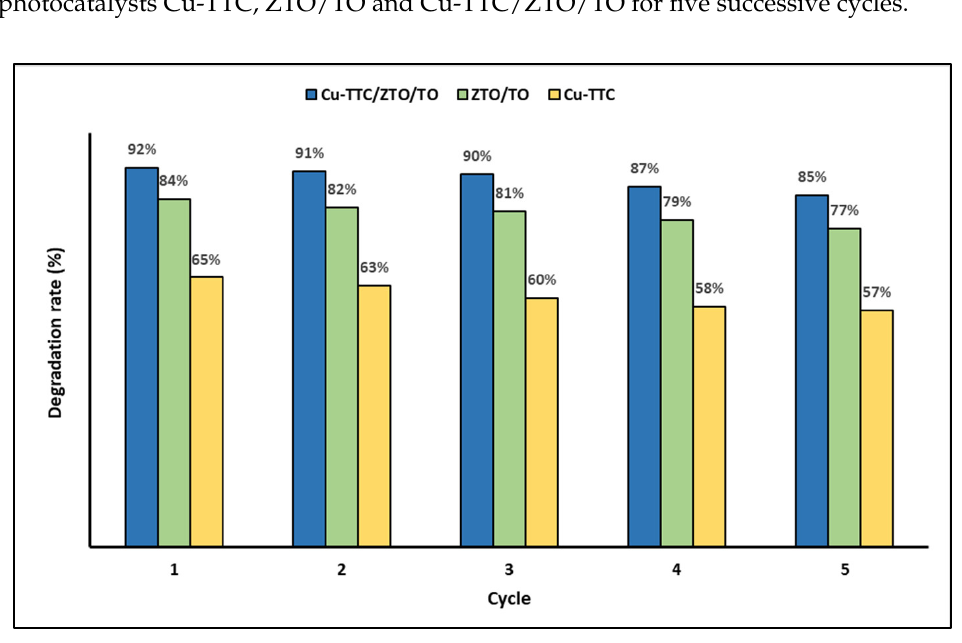
Figure 7. Degradation percentage of MB dye for five photocatalytic cycles.